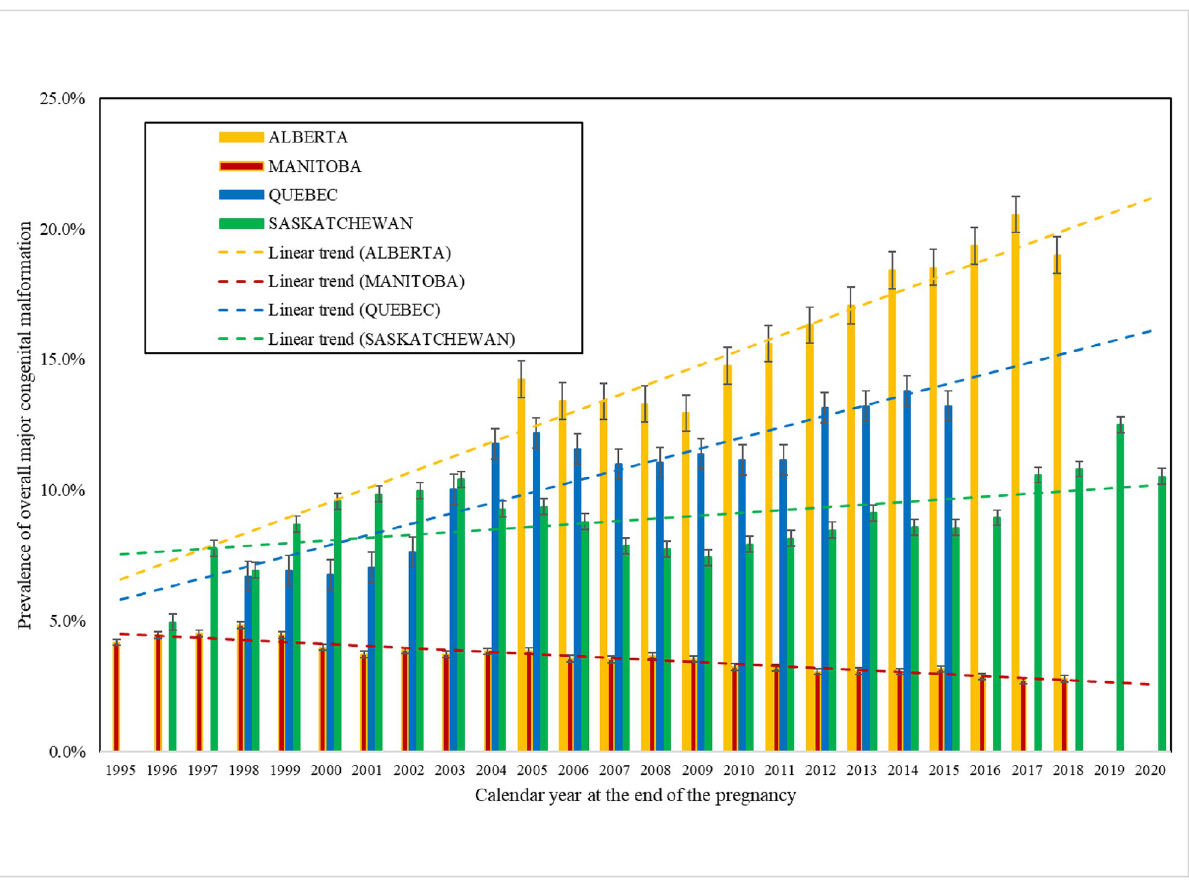
Fig 3. CAMCCO—Quebec, Manitoba, Saskatchewan, and Alberta—Annual rates of major malformations in the first year of life with trends for each province. Note: Trend comparisons between provinces p < 0.0001.